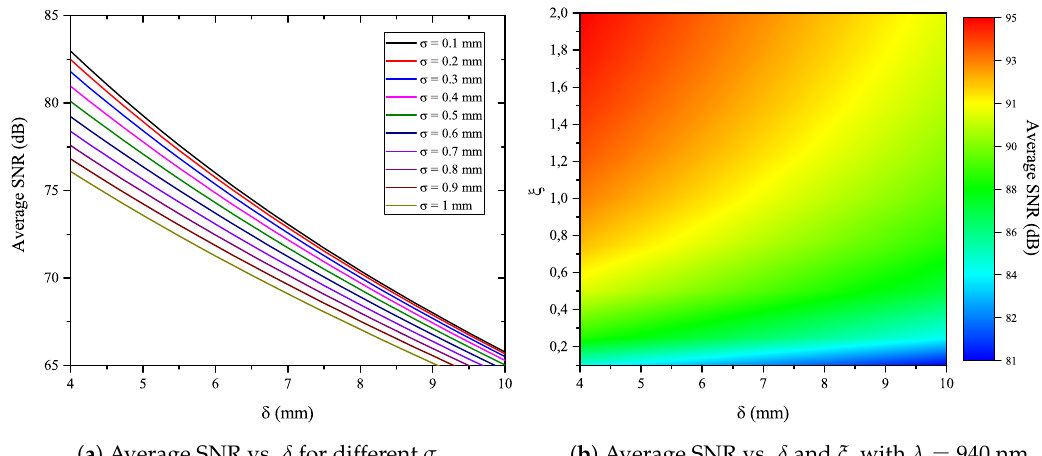
Figure 3. Impact of pointing